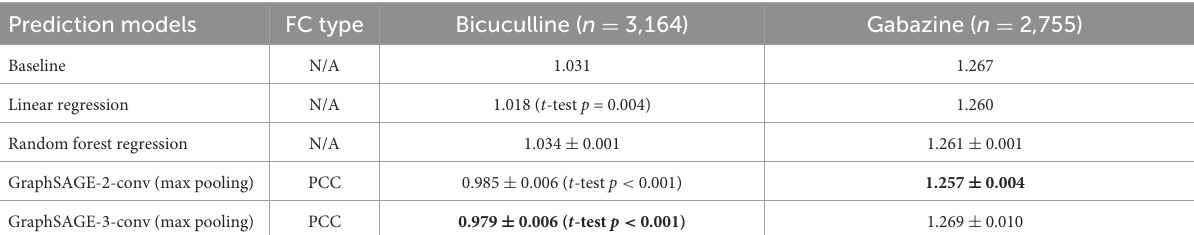
TABLE 3 Performance comparison (test dataset and average